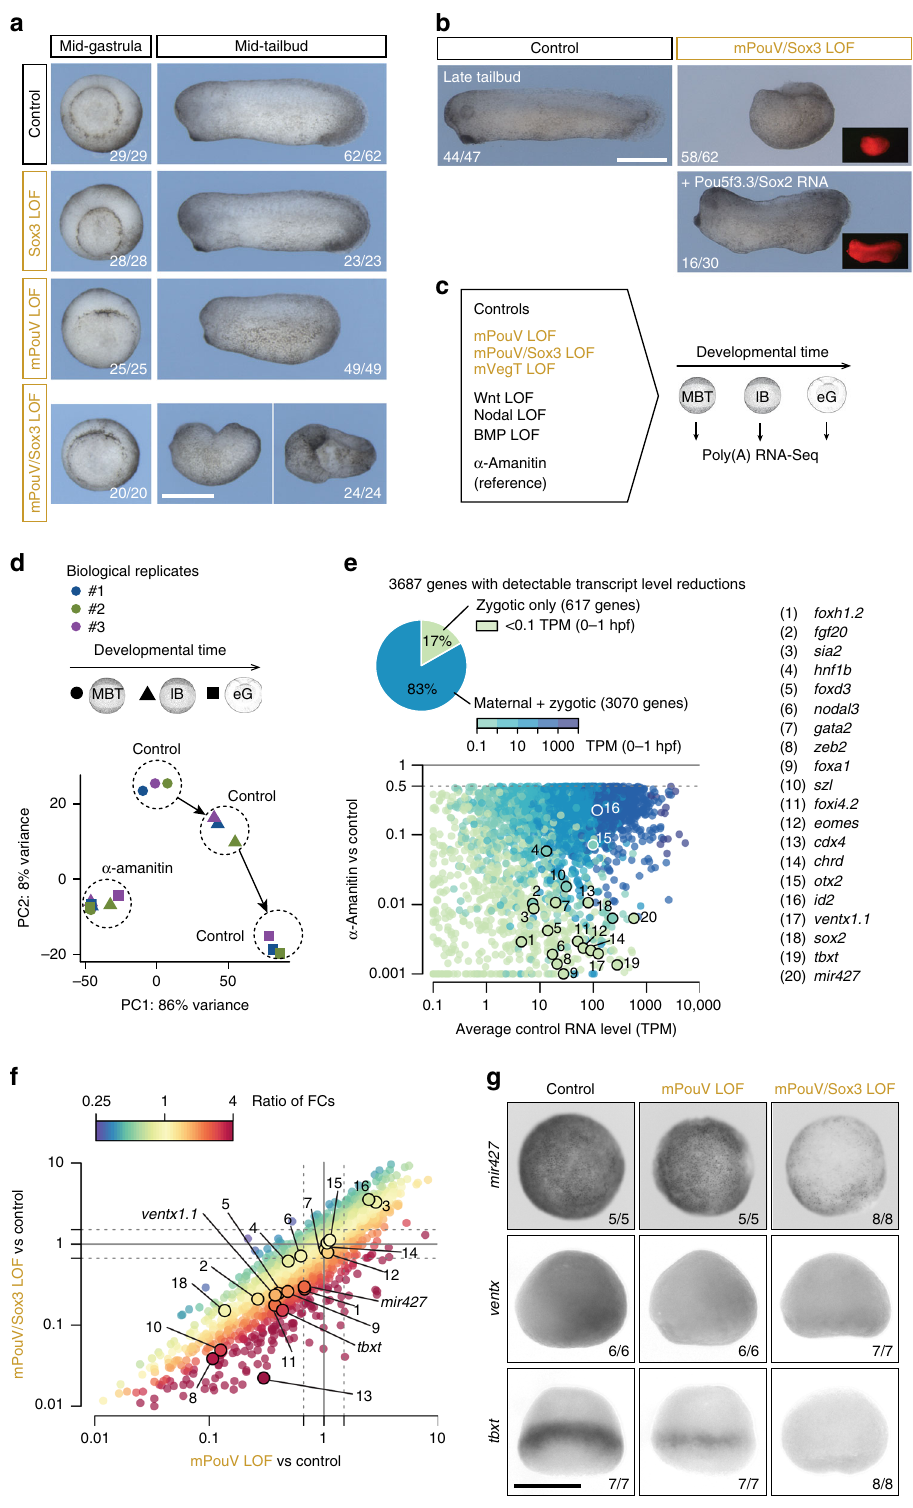
pCRMs (super-enhancer) of tbxt contain canonical POU/SOX motifs, so were not accessible to Smad2 in mPouV/Sox3 LOF embryos (Fig. 10a, b). Thus, Smad2 interactions with critical Nodal responsive CRMs of eomes remained intact, but those of tbxt were impeded by compacted chromatin. Pioneer-initiated competence also applied to Wnt signalling with β -catenin failing to engage with Wnt responsive CRMs of foxb1 in the absence of